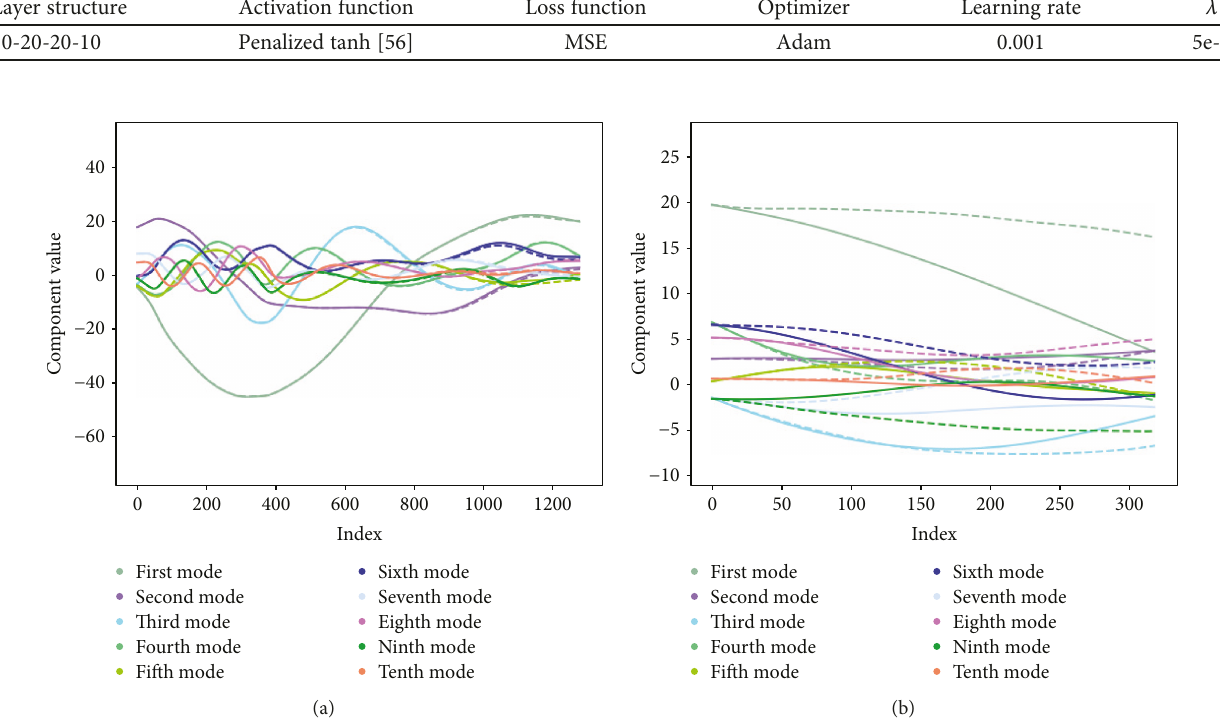
Figure 20: A posteriori comparison between prediction of Jacobian regularized model and ground truth for POD coe ffi cient of buoyant mixing fl ow. Dashed: model. Solid: ground